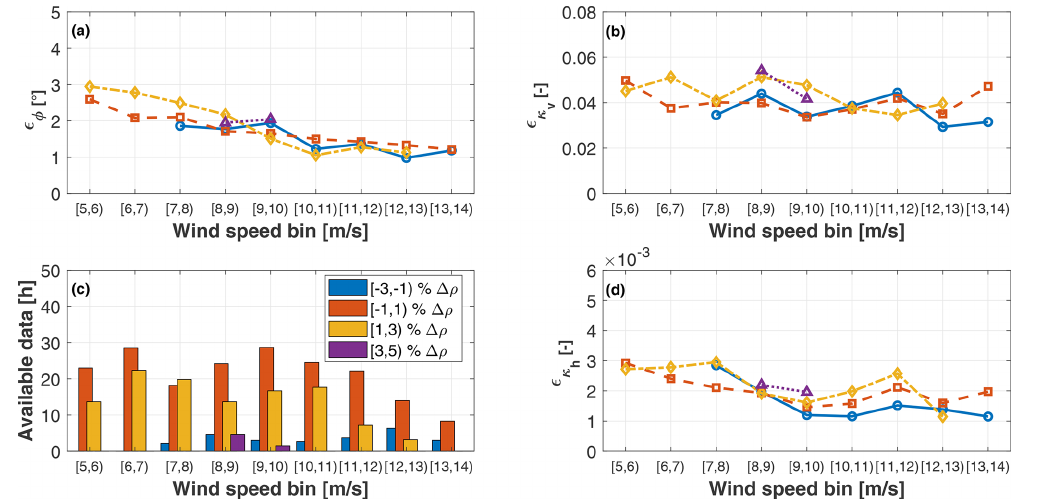
Figure 11. MAE (cid:15) vs. binned rotor-effective wind speed for binned density change (cid:49)ρ with respect to standard air. Yaw misalignment (a) ; vertical shear (b) ; hours of available data (c) ; horizontal shear (d)